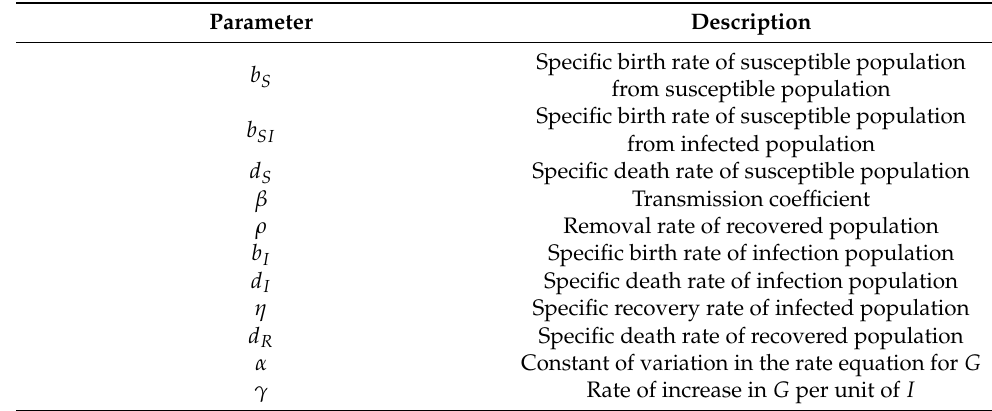
Table 1. List of parameters in porcine reproductive and respiratory syndrome virus (PRRSV) model and their